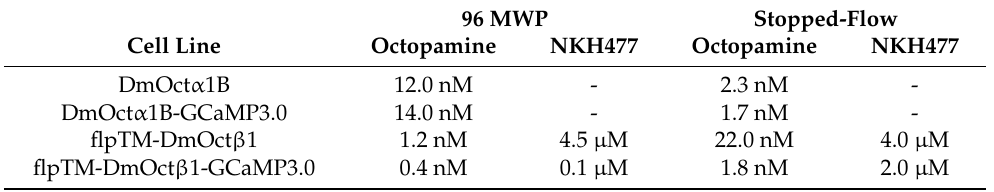
Table 3. EC 50 values obtained in fluorimetric measurements in 96 multi well plates and in stopped- flow experiments with DmOct α 1B and flpTM-DmOct β 1 cell lines. EC 50 values for octopamine and NKH477 were determined with Fluo-4-loaded or GCaMP3.0-expressing cell lines. Experiments with flpTM-DmOct β 1 and flpTM-DmOct β 1-GCaMP3.0 cells were performed in the presence of 100 µ M